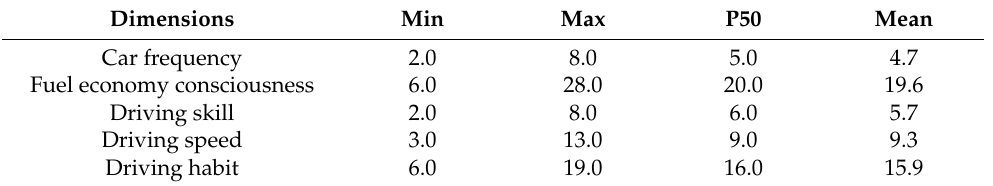
Table 5. Descriptive statistics of